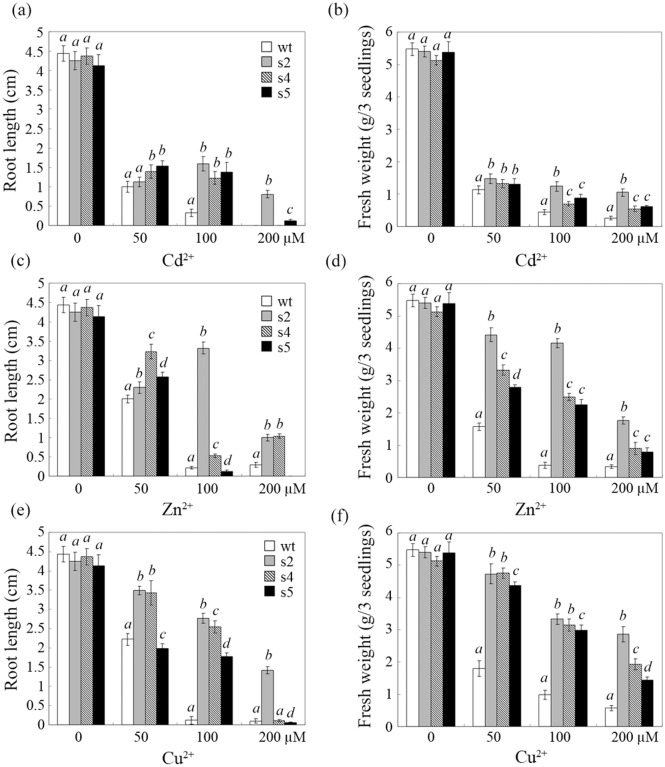
Comparative analysis of the root length and fresh weight of transgenic lines under heavy metal stress.Root lengths (a, c and e) and fresh weights (b, d and f) of transgenic sugar beets overexpressing StGCS-GS (s2, s4 and s5) and wild-type sugar beets (wt) were measured after 3 weeks of treatment with 0, 50, 100 or 200 μM Cd2+, Zn2+ or Cu2+. The experiments were performed in triplicate, and the values are presented as the means ± SD. Means denoted by the same italicized letter did not differ significantly (P<0.05).